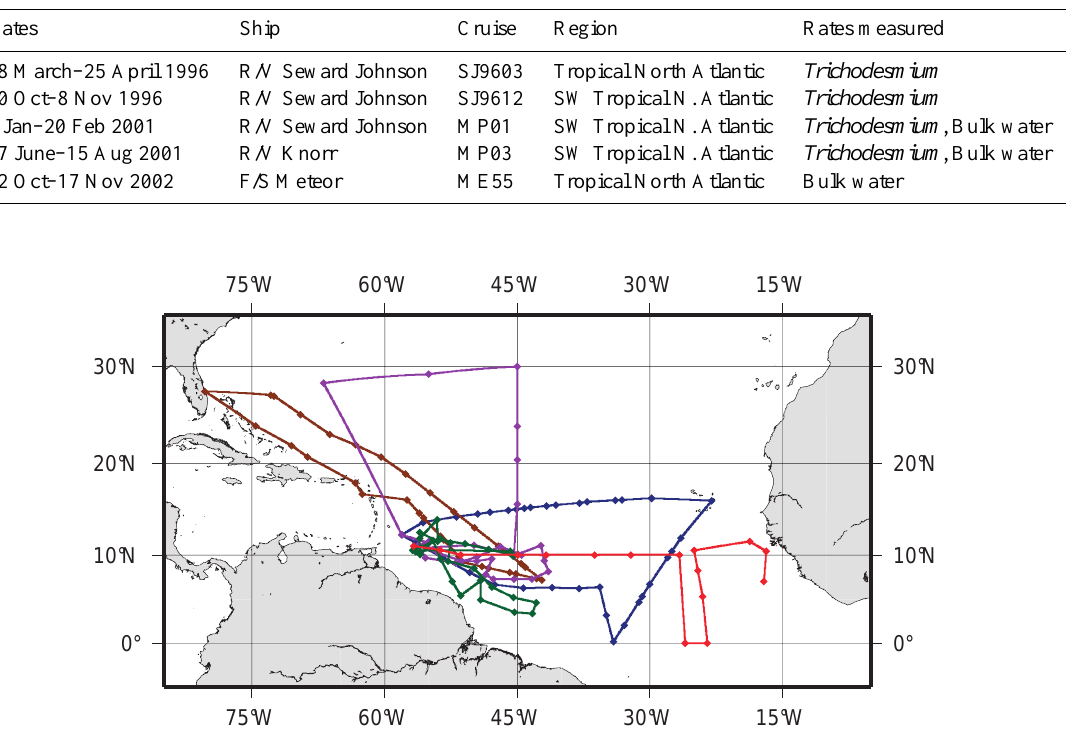
Fig. 1. Tracks of the five cruises included in this study: SJ9603 (dark blue), SJ9612 (brown), MP01 (purple), MP03 (green), and ME55 (red). Chart prepared with GMT (Wessel and Smith,